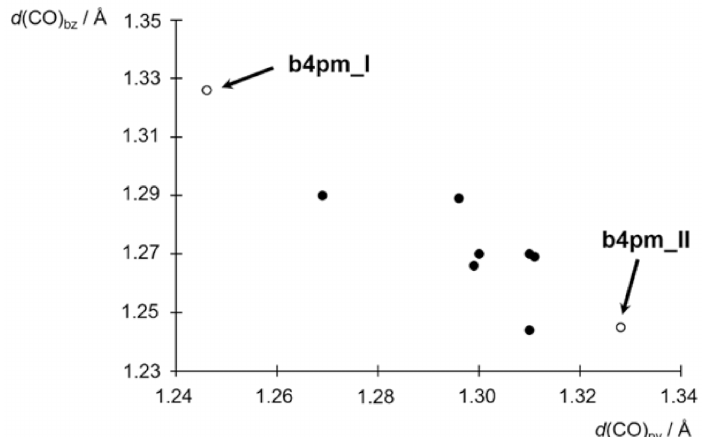
Figure 11. The interrelation between CO bond lengths in b4pm molecule; black circles—cocrystals, white circles—optimized